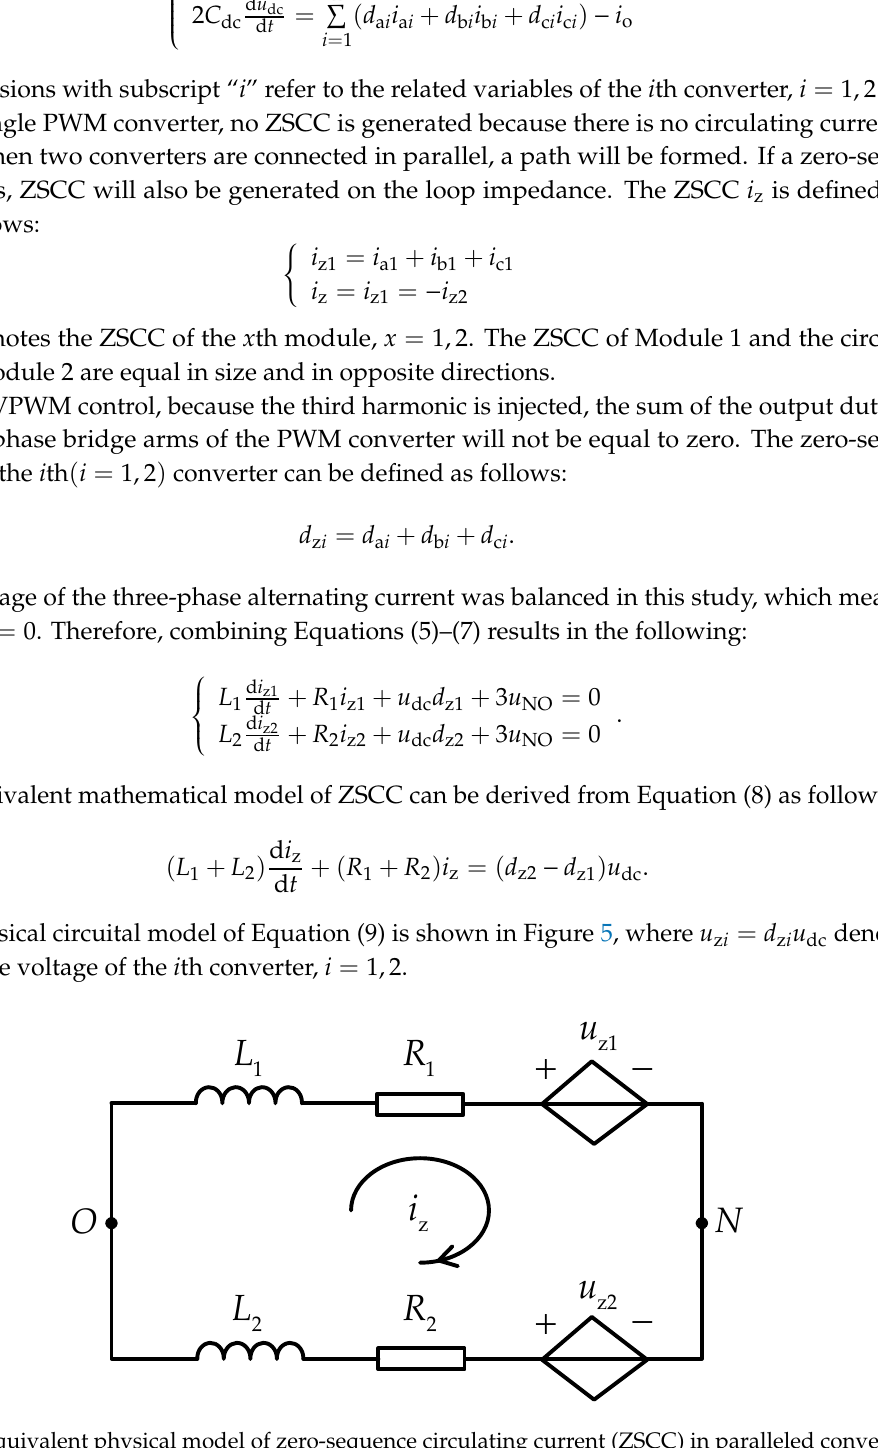
Figure 5. Equivalent physical model of zero-sequence circulating current (ZSCC) in paralleled converters.